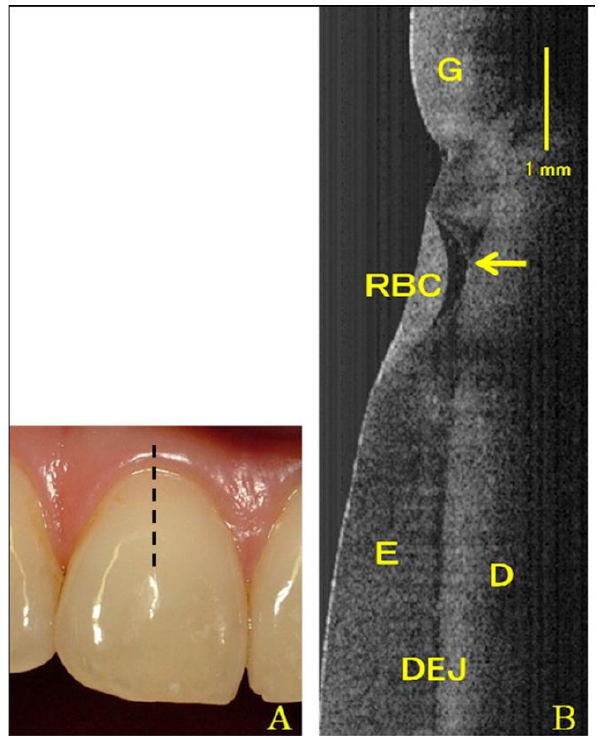
Figure 6. Photogragh ( A ) and SS-OCT image ( B ) of Class V restoration in the central incisor. Arrow shows microleakage formation beneath resin material (G: gingival; RBC: resin based composite; E: enamel; D: dentin; DEJ: dental enamel junction) (reprinted from reference